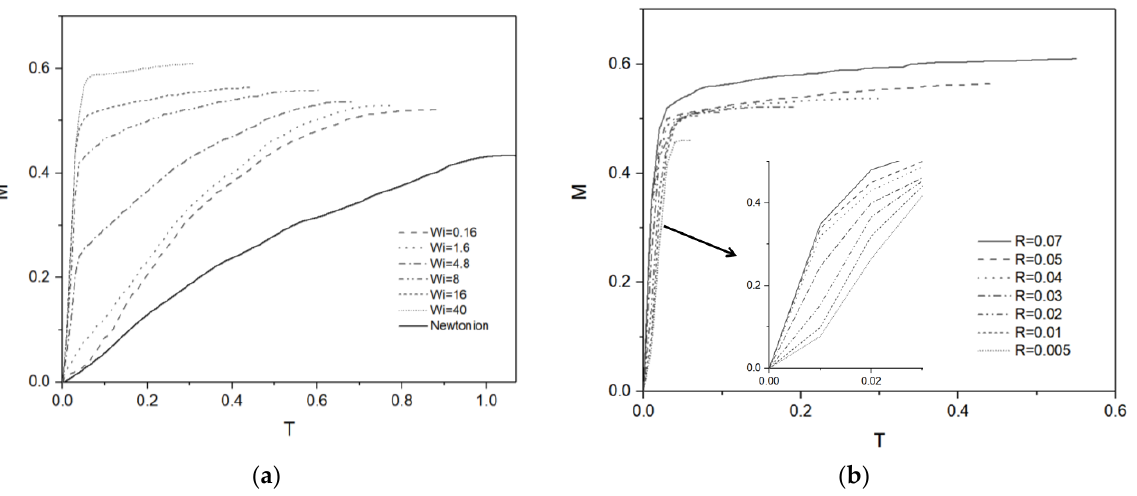
Figure 3. ( a ) Migration of Newtonian droplet and viscoelastic droplets with different Wi numbers against dimensionless time. ( b ) Migration of a viscoelastic droplet ( Wi = 16) of different initial radii.